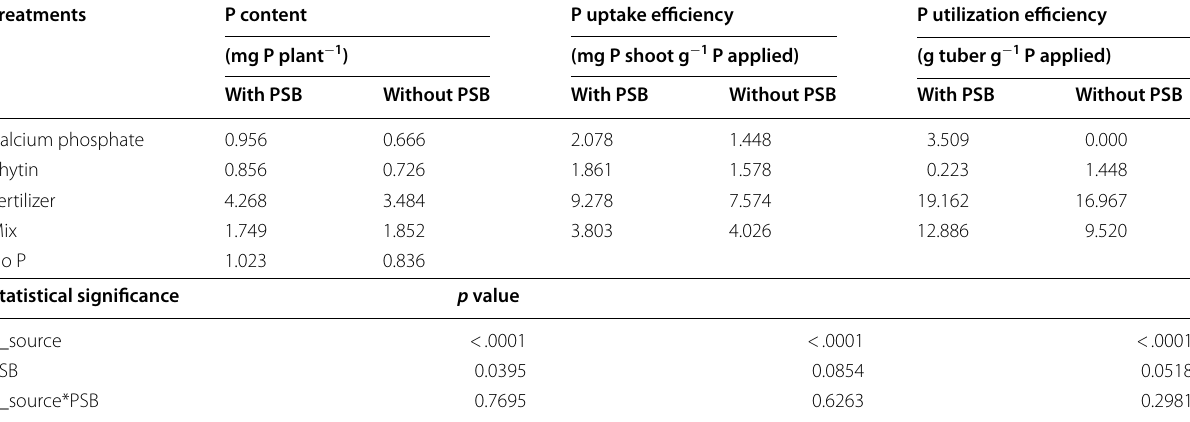
Table 2 Phosphorus use efficiencies of potato plants amended with four P sources and a control in greenhouse conditions with and without inoculation of a consortium of P-solubilizing bacteria Treatments